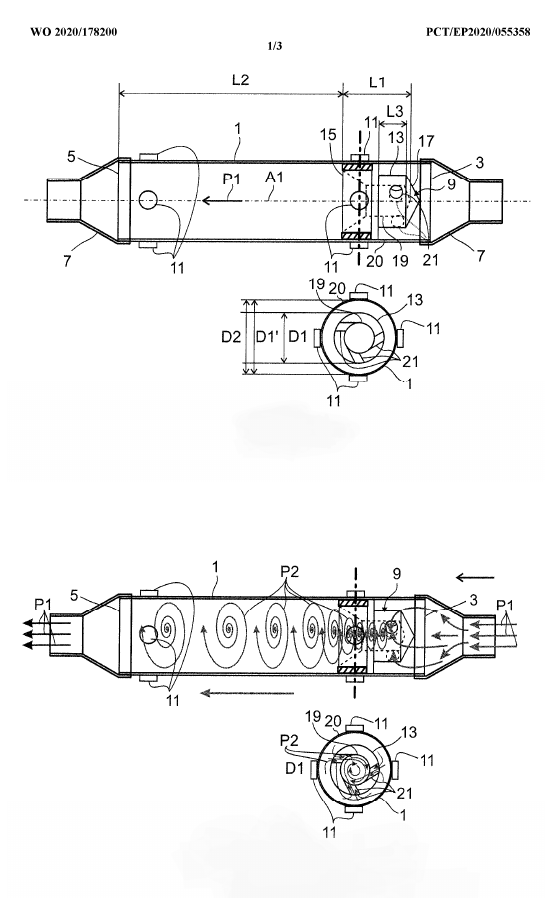
Figure 5. The EVOdrop filter.